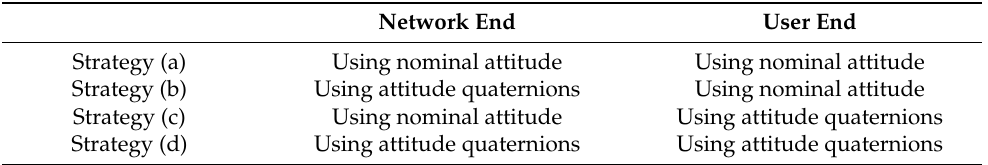
Table 2. Attitude quaternions using strategies to investigate the impact on integer clock